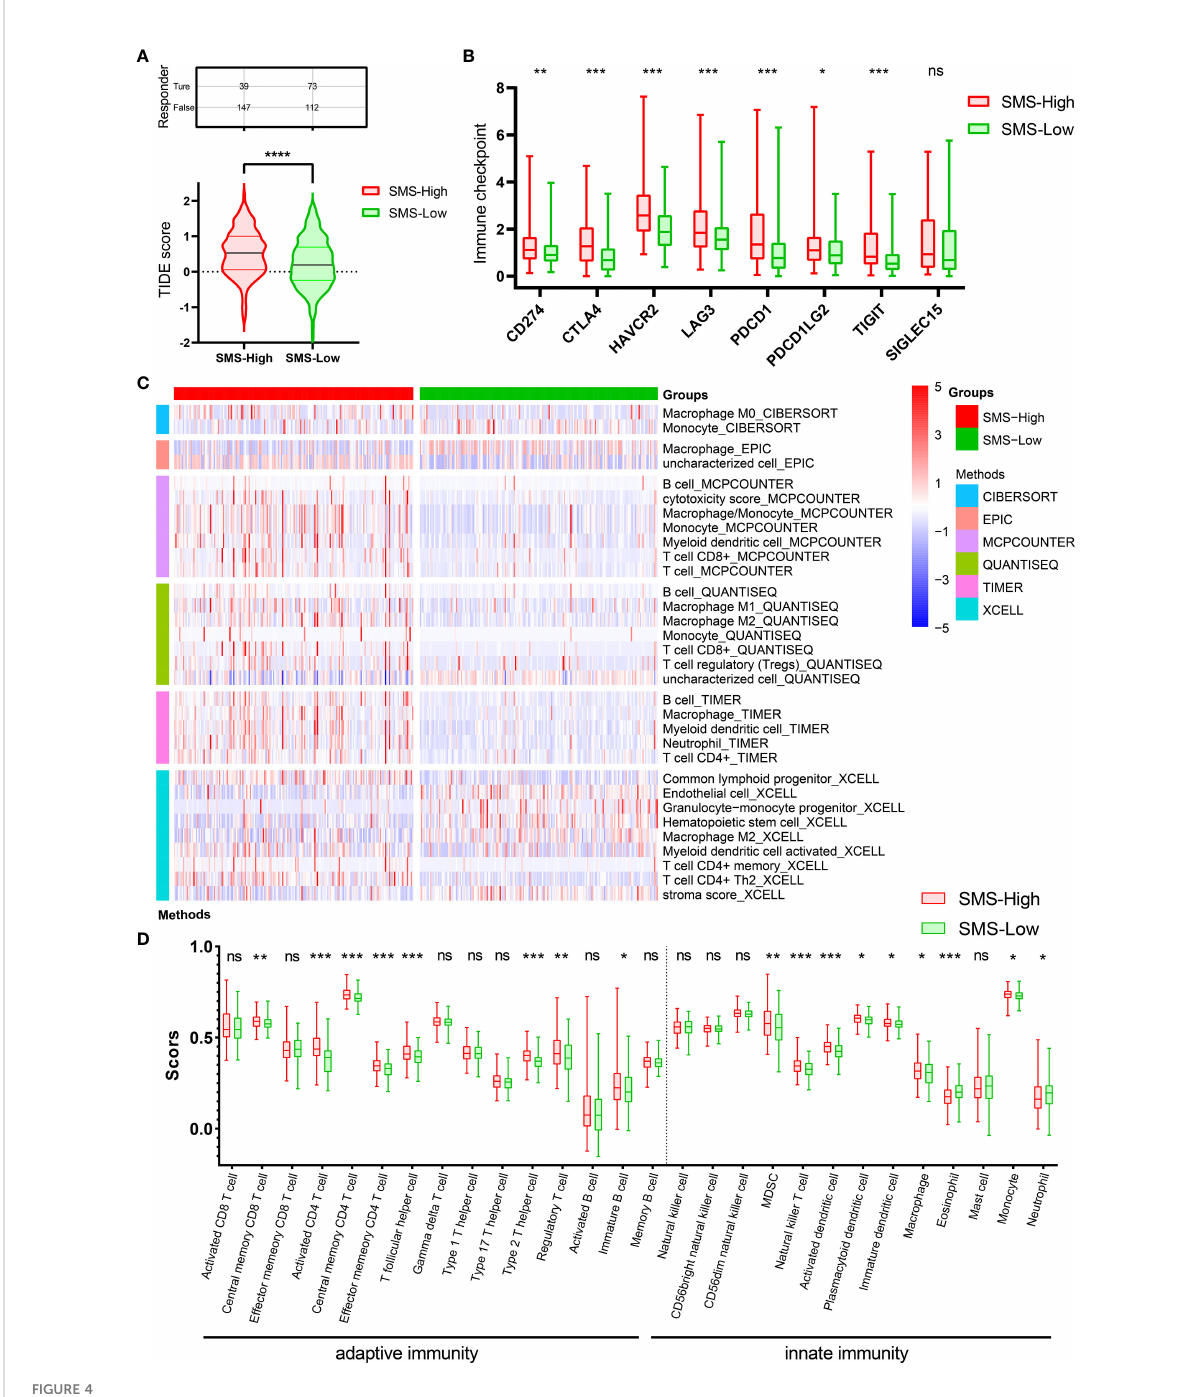
FIGURE 4 ICB immunotherapy response predict and Immune in fi ltration analysis. (A) Differences in TIDE prediction score between the indicated groups. (B) Expression of immune checkpoints between the indicated groups. (C) Heatmap of immune responses between the indicated groups. (D) ssGSEA immune cells scores between the indicated groups in boxplots. *p<0.05, **p<0.01, ***p<0.001, ****p<0.0001 vs. indicated control, ns, no signi fi